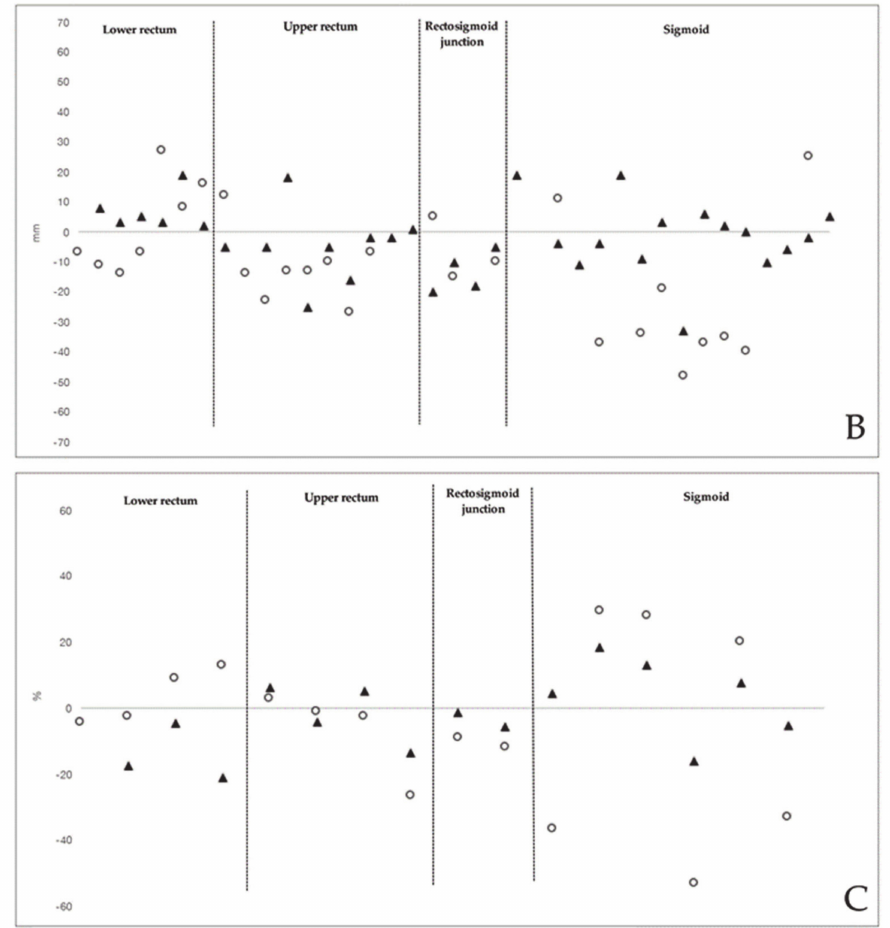
Figure 3. ( A ) Di ff erence (mm) between imaging methods and surgery in estimating the largest diameter of endometriotic rectosigmoid nodules; ( B ) di ff erence (mm) between imaging methods and surgery in estimating the distance from the lowest endometriotic rectosigmoid nodule and the anal verge; ( C ) Di ff erence (%) between imaging methods and surgery in estimating the stenosis of bowel lumen due to the endometriotic nodules (calculated in patients undergoing colorectal segmental resection). White circles: 3D-RWC-TVS; black triangles: